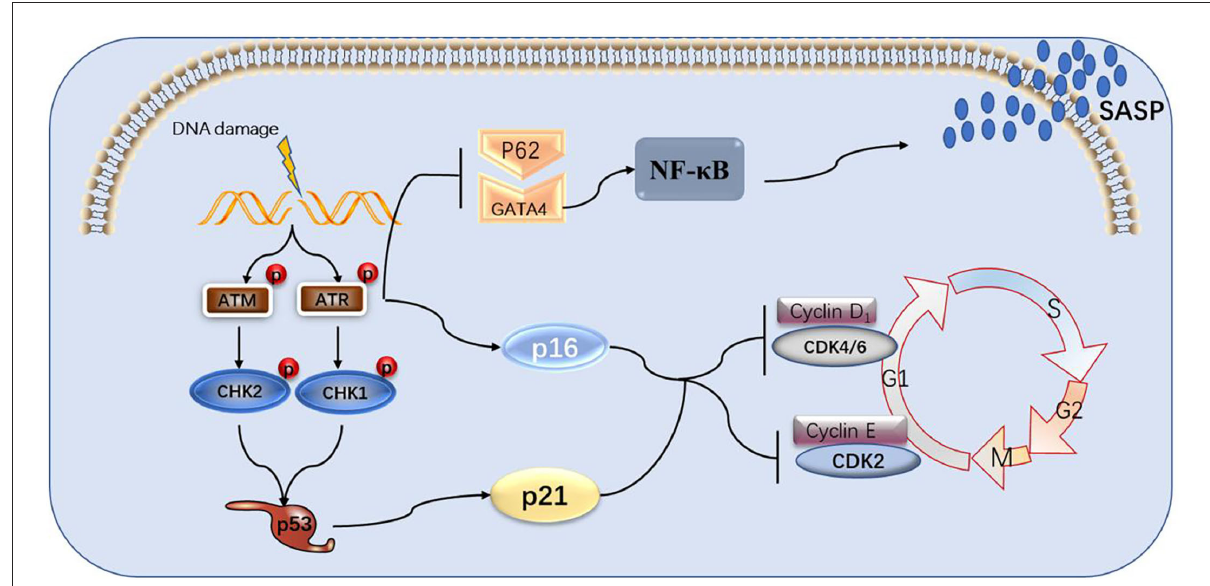
FIGURE1 The role of GATA4 in atherosclerosis and myocardial hypertrophy. The GATA4-TWIST1-Snail signaling pathway promotes EC dysfunction and atherosclerosis. GATA4 may regulate cell hypertrophy by increasing the expression level of GATA4, DNA binding activity, and transcriptional activity under the stimulation of the hypertrophy